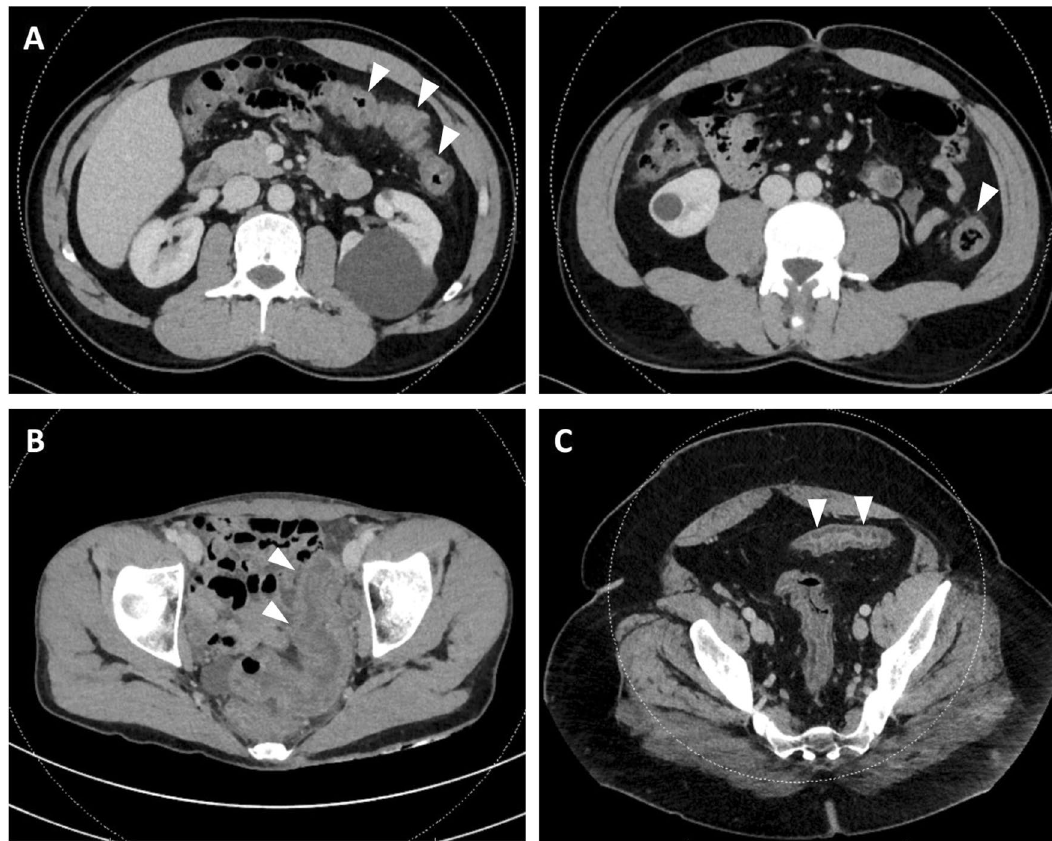
Figure 1. Computed tomography of episode of acute colitis. Arrows indicate areas of colonic inflammation with colonic wall thickening and infiltration of pericolonic fat. ( A1 + 2 ) 46 yo male patient with infectious colitis due to Campylobacter jejuni . ( B ) 31 yo female patient with undetermined colitis. ( C ) 42 yo male patient with infectious colitis due to Shigella sonei